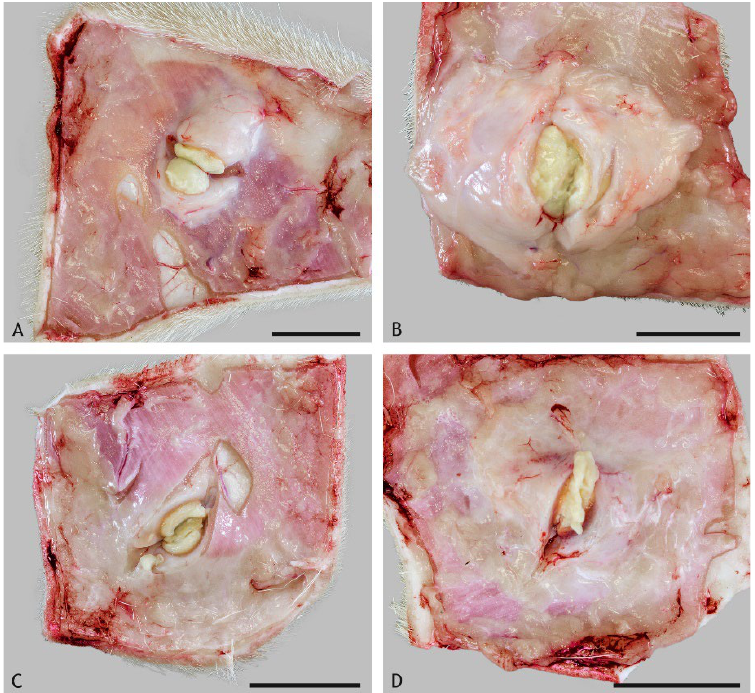
Figure 1. Gross morphology of caseous granulomas induced by the subcutaneous injection of BCG (( A ), goat 28), VPM1002 (( B ), goat 9), PDX (( C ), goat 18) and NUOG (( D ), goat 26) after incision. The necrotic material was firm, resulting in a smooth cut-surface in BCG- and PDX-induced granulomas and a soft, bulging out cut-surface in VPM1002- and NUOG-induced granulomas. Scale bars = 2 cm.